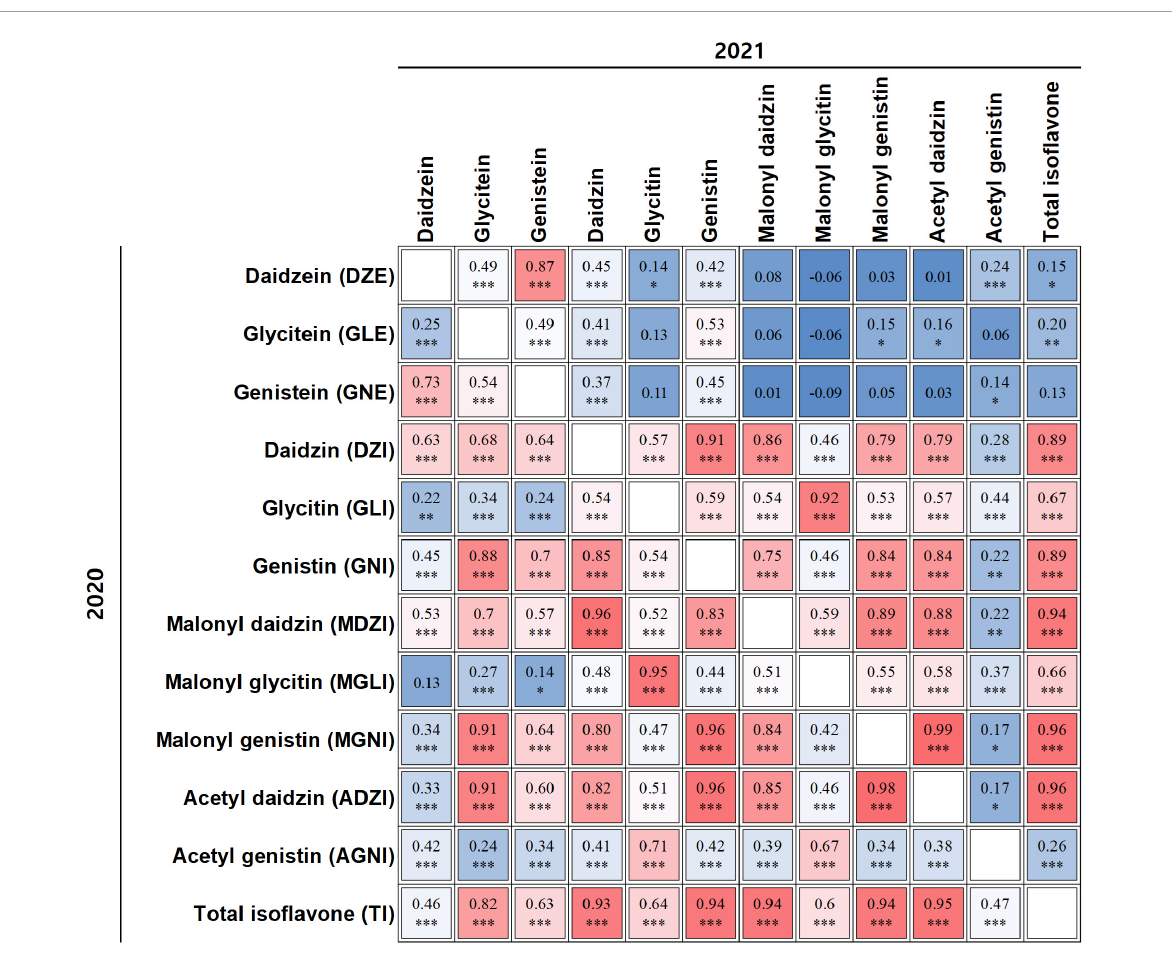
FIGURE2 Correlation analyses among individual isoflavones and total isoflavones. Correlation coefficient in upper panel relates to isoflavone content data from 2021; that in lower panel relates to isoflavone content data from 2020. ∗ , ∗∗ , ∗∗∗ , and indicate significance at p < 0.05, 0.01, 0.001, and not significant,